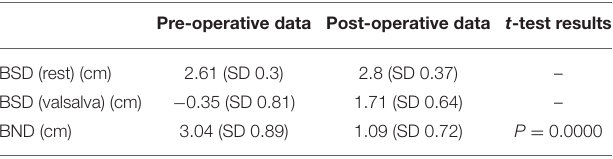
TABLE 4 | Six-month follow-up transperineal ultrasound measurement